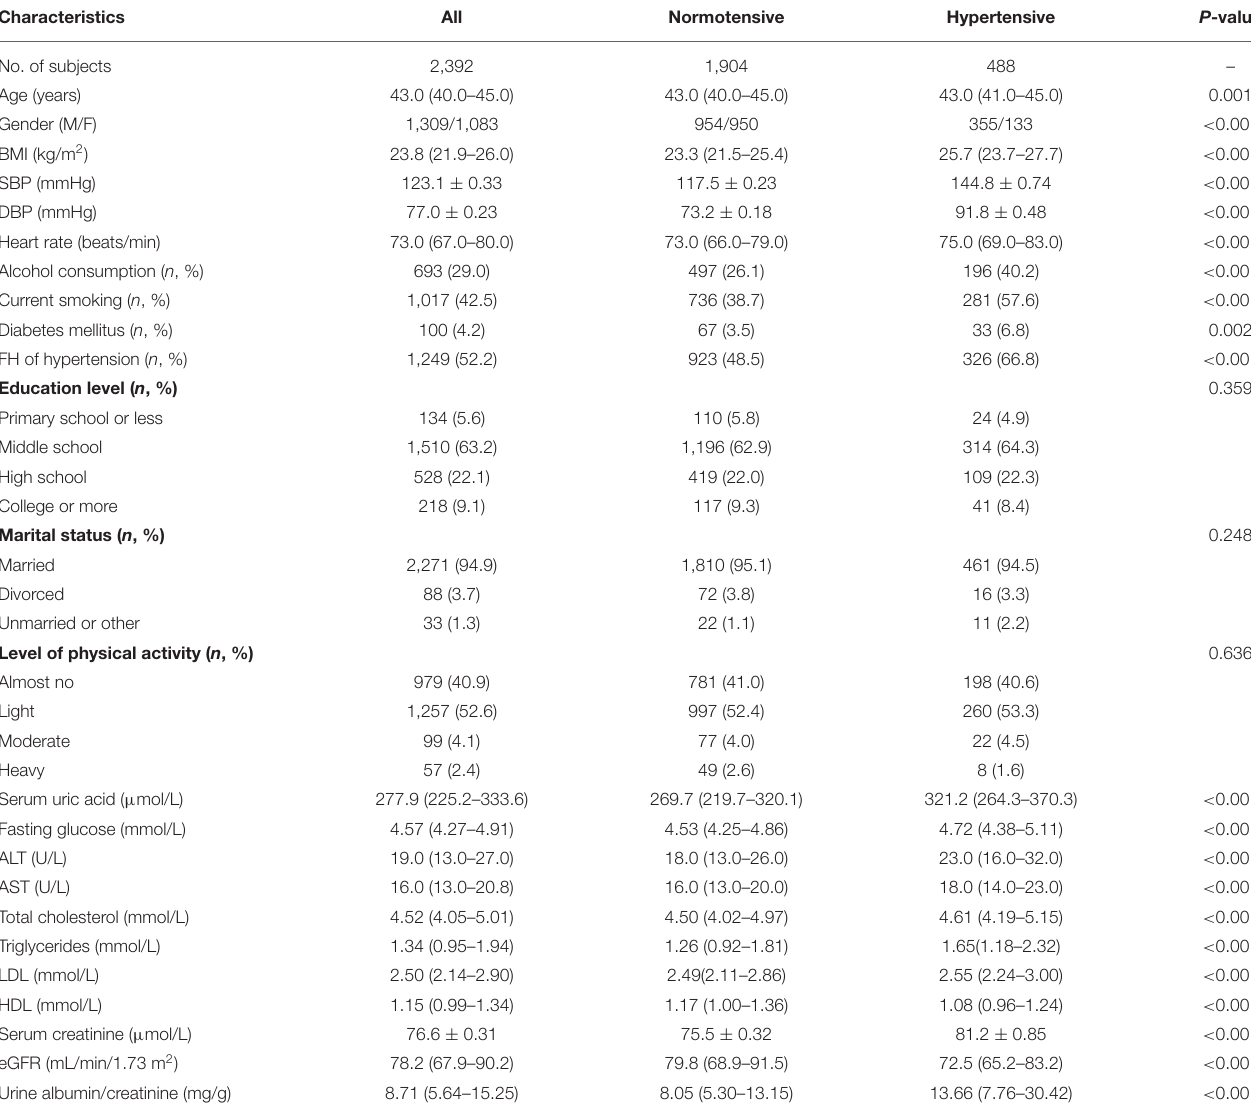
TABLE 5 | Characteristics of participants categorized by BP status in the cross-sectional cohort study ( n = 2,392). Characteristics